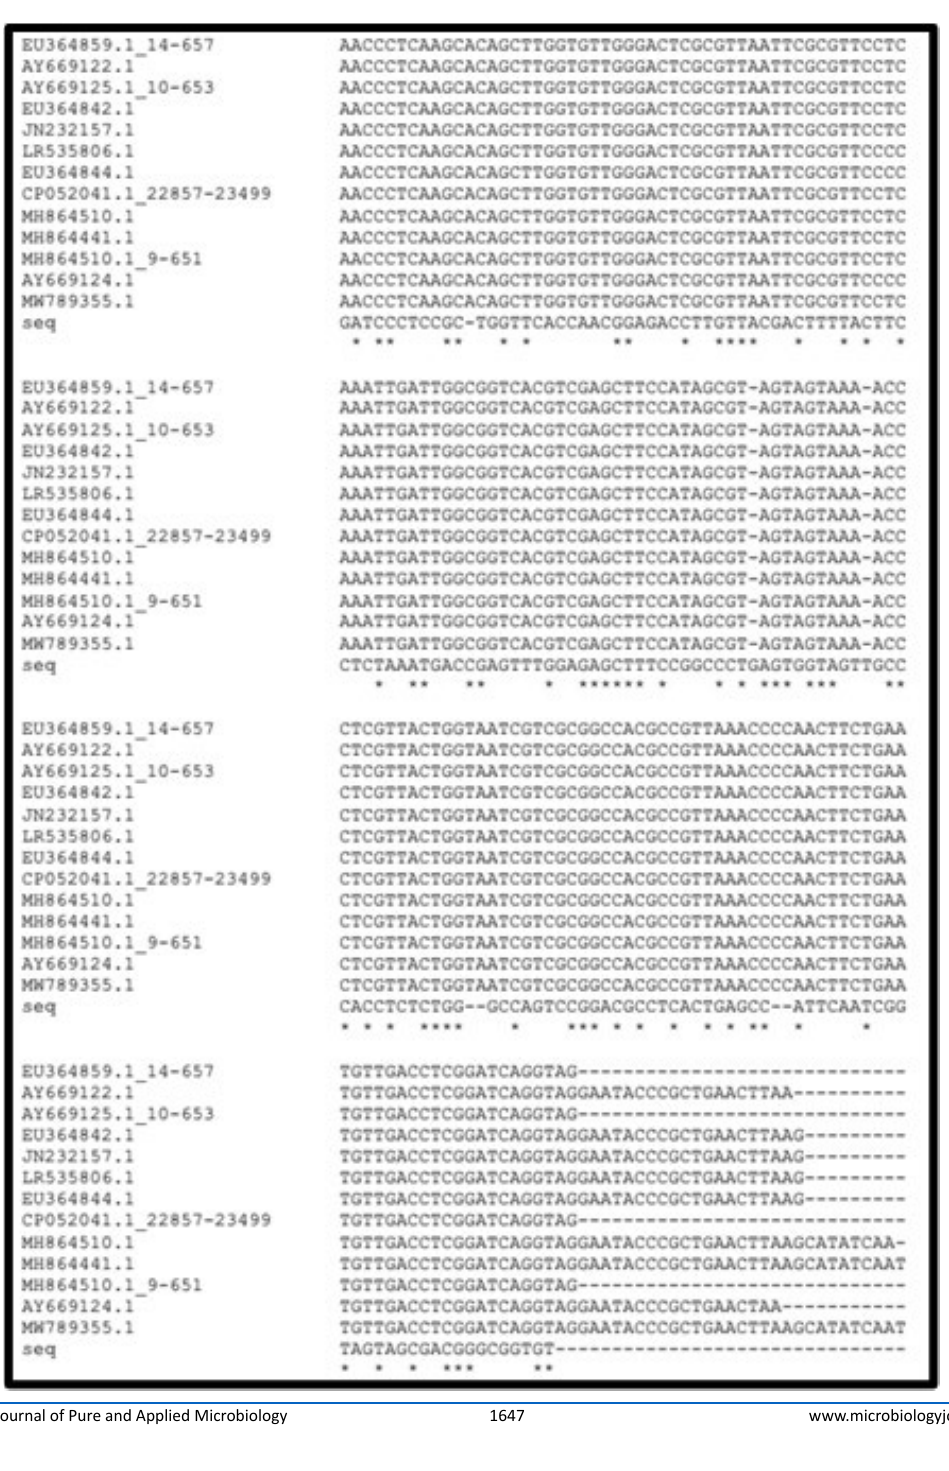
ribosomal RNA sequences to partial gene of 18S ribosomal RNA at the internal transcribed spacer 1, and complete sequence of 5.8S ribosomal